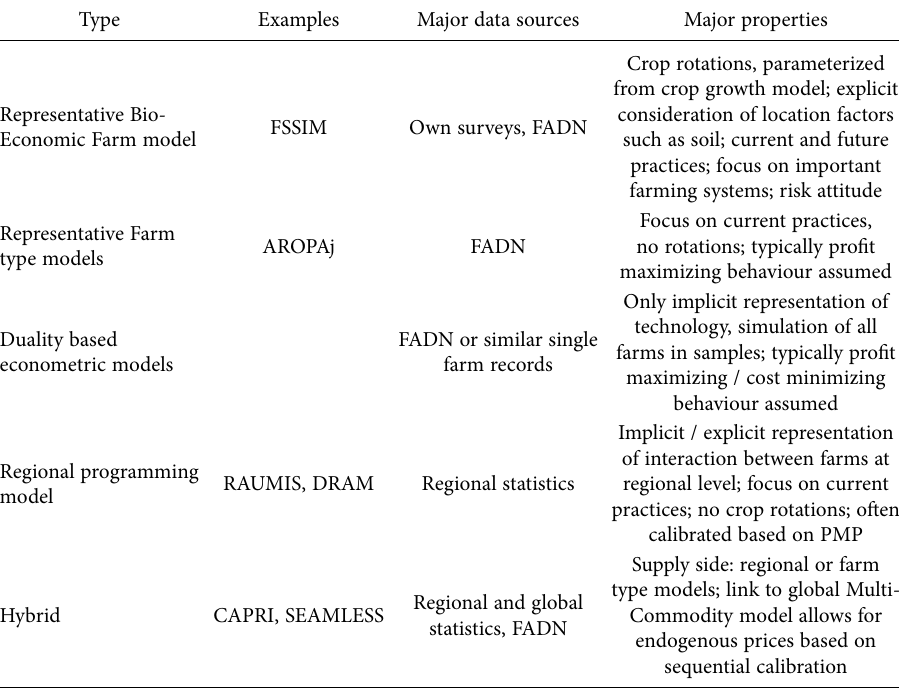
Table 1. Overview of approaches to model farm heterogeneity, scaling up and feedback